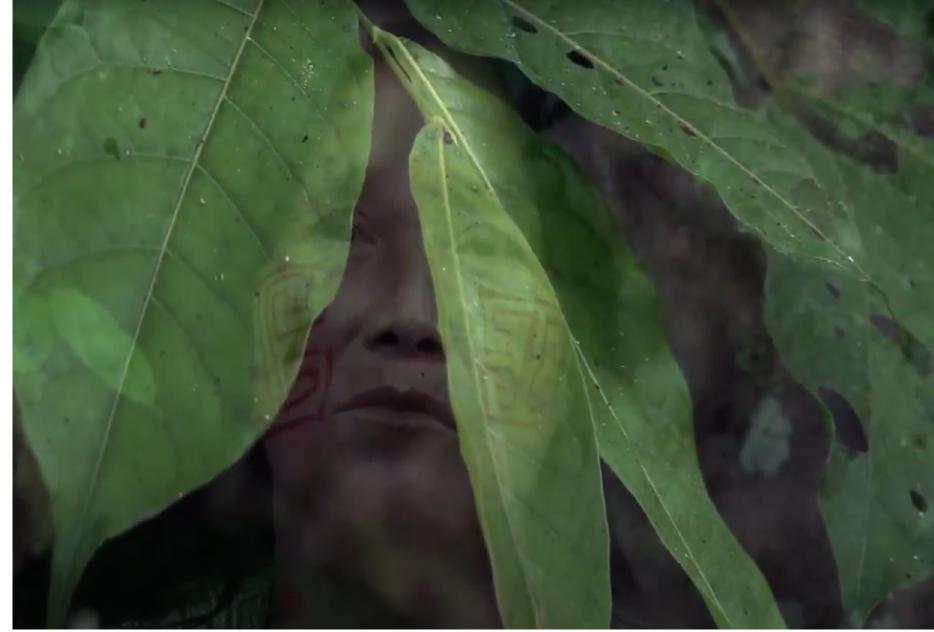
Figure 3. Still from Shuku Shukuwe .